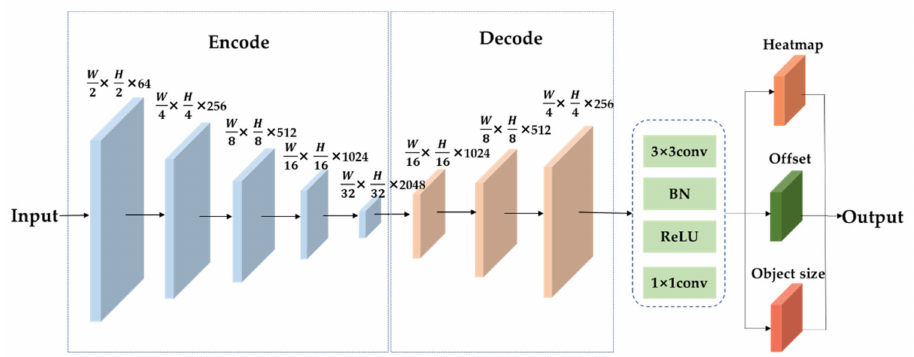
Figure 1. Overall structure of CenterNet based on